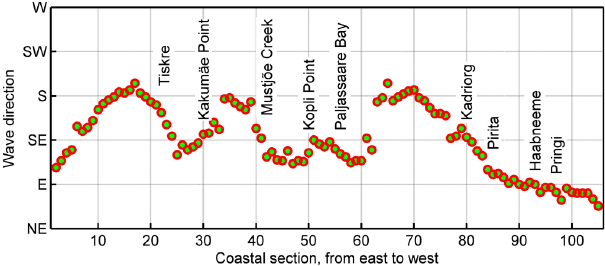
Fig. 4. Wave propagation directions corresponding to the highest waves that occurred in the study area in 1981–2012. Differing from meteorology, wave modellers indicate the direction in which waves